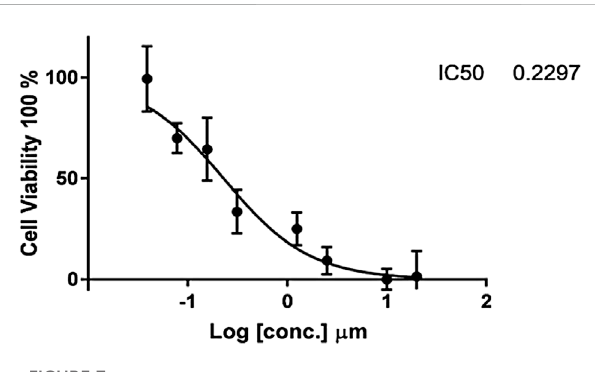
FIGURE 7 Viability test of compound IIB against the A549 cell